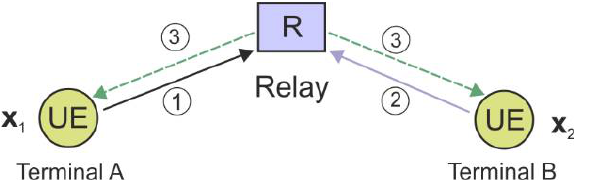
Figure 1. General scheme of a two-way relaying system with standard network coding.